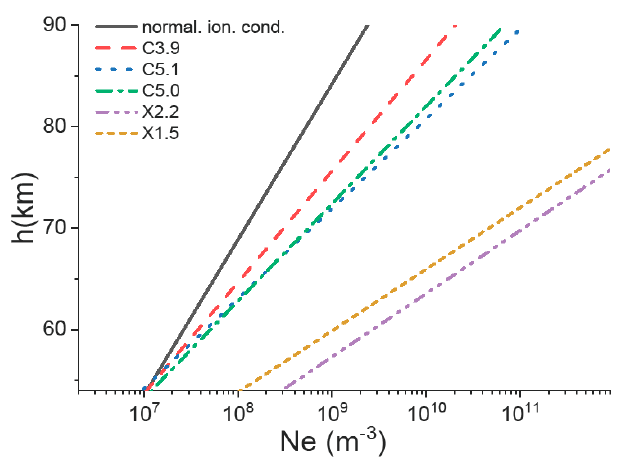
Figure 9. The height profile of electron density at peak time for five successive flares on 10 June 2014.